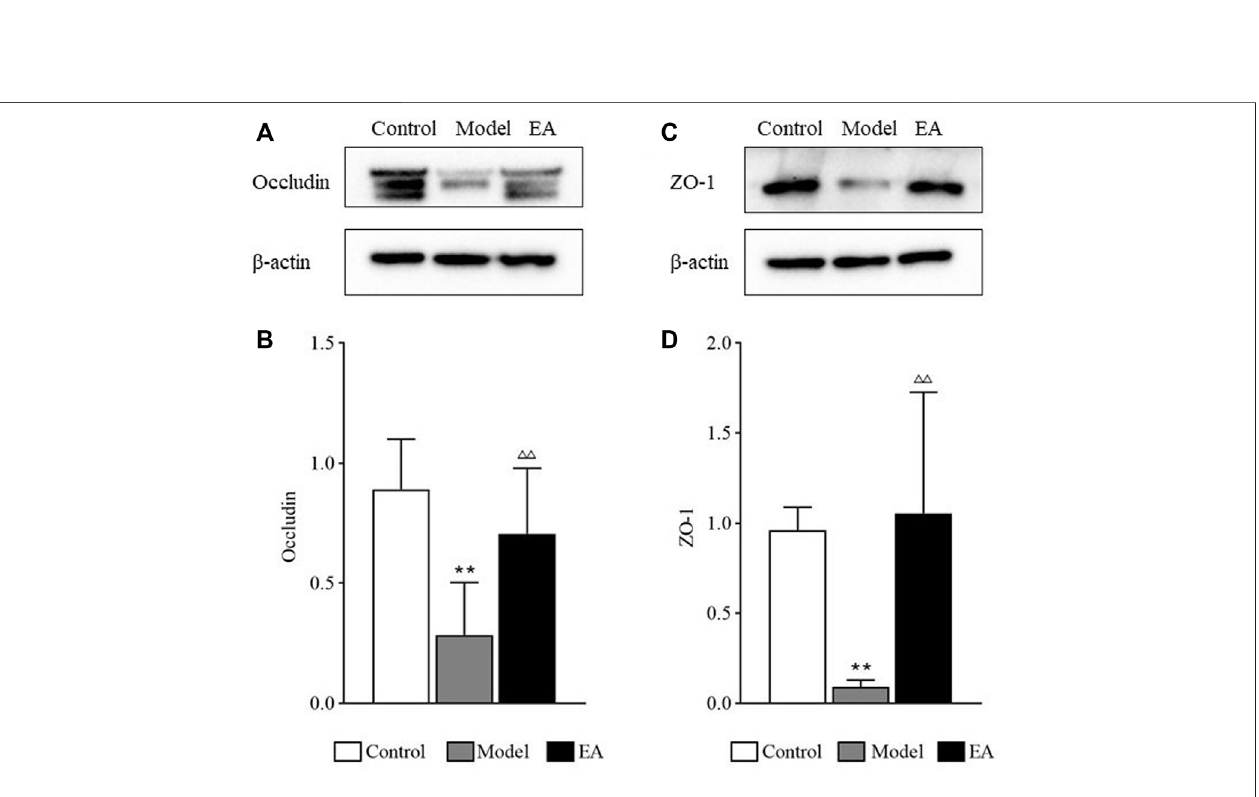
Frontiers in Physiology |